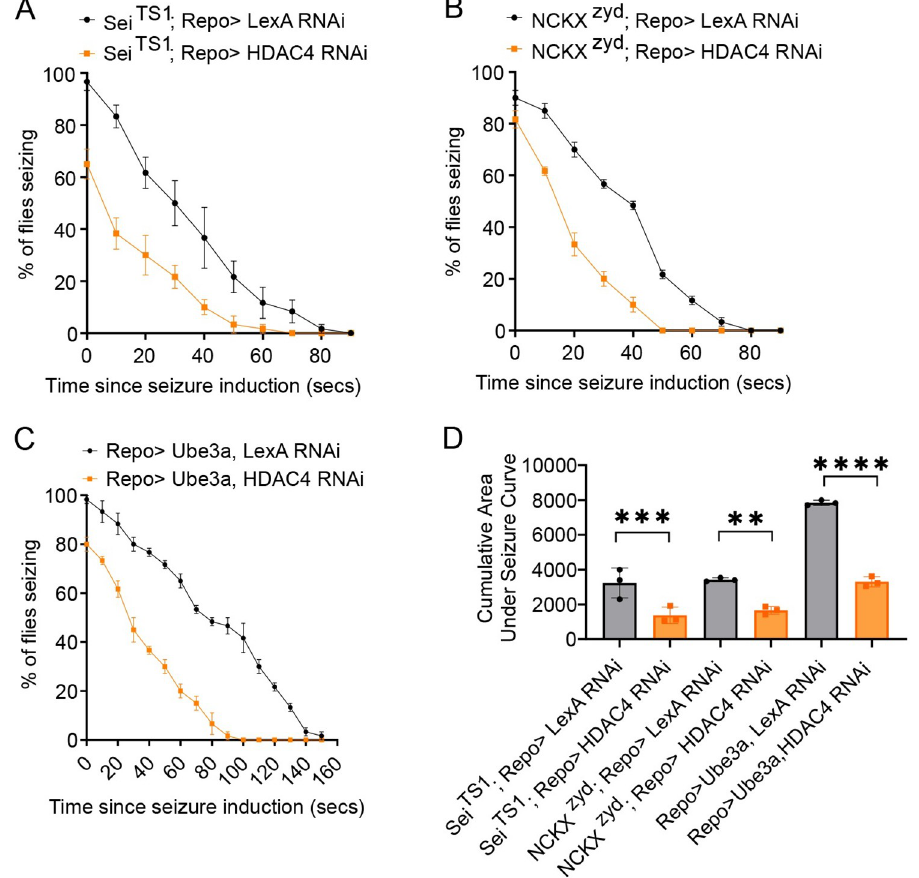
Fig 2. Enhancing glial K + buffering suppresses seizure behavior. (A) Time course of heat shock induced seizure behaviors. Pan glial driver, Repo-Gal4, was used to express control transgene, UAS-LexA RNAi (Sei TS1 Repo > ), or UAS-HDAC4 RNAi (Sei TS1 Repo > HDAC4 RNAi). After seizure induction, the number of flies seizing were recorded every 10 seconds and plotted as a percentage of seizing flies. n � 3 groups of 10–20 flies per genotype per time point. (B) Time course of heat shock induced seizure behaviors. Pan glial driver, Repo-Gal4, was used to express control transgene, UAS-LexA RNAi (NCKX zyd Repo > ), or UAS-HDAC4 RNAi (NCKX zyd ;Repo > HDAC4 RNAi). After seizure induction, the number of flies seizing were recorded every 10 seconds and plotted as a percentage of seizing flies. n � 3 groups of 10–20 flies per genotype per time point. (C) Time course of vortex-induced seizure behaviors. Pan glial driver, Repo-Gal4, was used to express control transgene, UAS-LexA RNAi (Repo > Ube3A, LexA RNAi), or constitutively active Fray (Repo > Ube3A, Fray T206E ). After seizure induction, the number of flies seizing were recorded every 10 seconds and plotted as a percentage of seizing flies. n � 3 groups of 10–20 flies per genotype per time point. (D) Quantification of area under seizure curve for genotypes in (A-C). Statistical significance was determined by one-way ANOVA with Sidak’s multiple comparisons test; �� p = 0.0010, ��� p = 0.006, ���� p < 0.0001. Data are mean ±